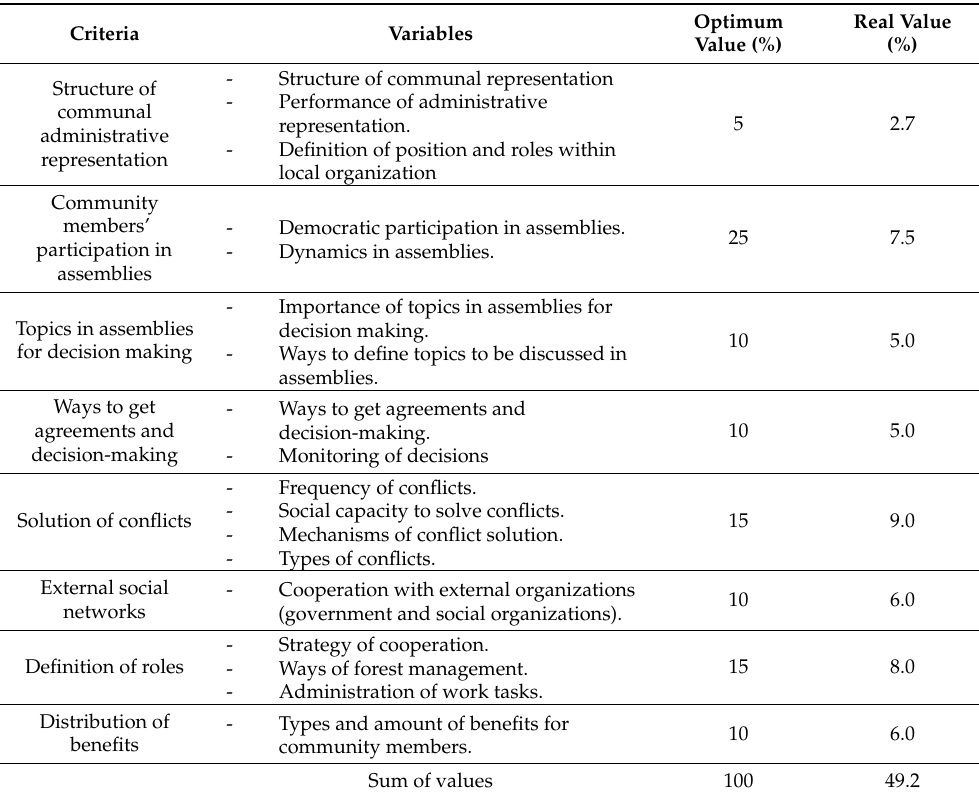
Table 9. Evaluation of specific indicators of local organization as part of community forest governance at San Miguel